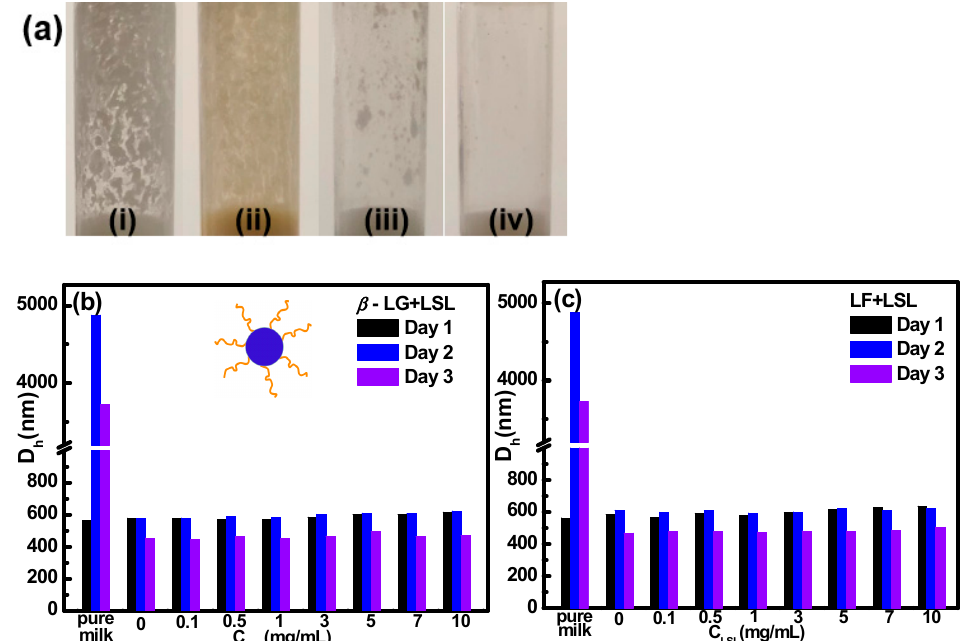
Figure 4. ( a ) Pictures of bo tt le walls of di ff erent lotions 3 days after placement. ( i ) The pure milk emulsion ( ii ) The milk emulsion with 4 g/L β − LG. ( iii ) The milk emulsion with 4g/L LF. ( iv ) The milk emulsion with 4 g/L LSL. ( b ) The milk particle size with β − LG − LSL at di ff erent LSL concentra- tions and at 298.2 K. ( c ) The milk particle size with LF − LSL at di ff erent LSL concentrations and at 298.2